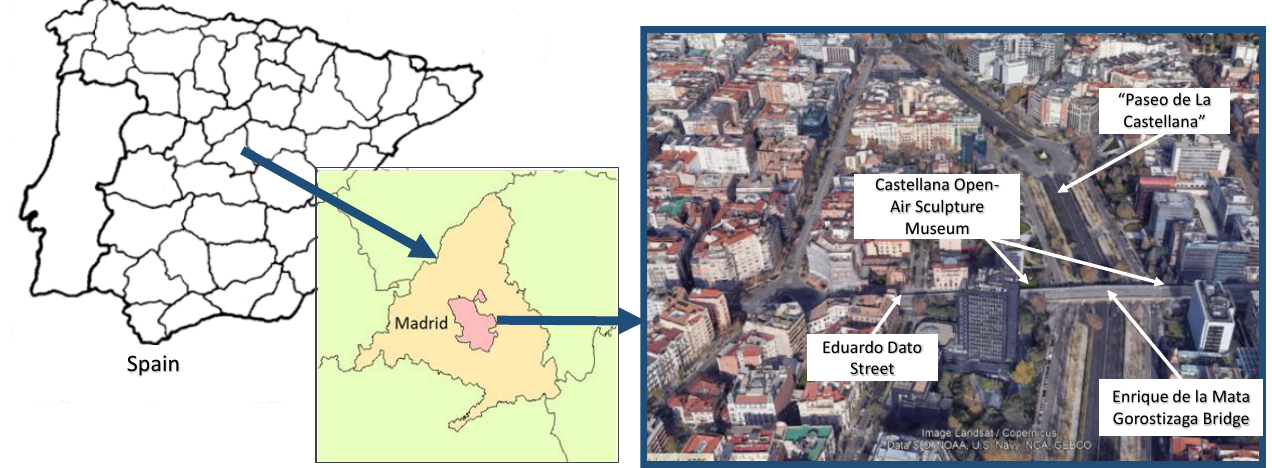
Figure 1. Location of the studied soil profile. The Madrid region forms part of the structural geographic unit commonly called the Central Plateau. In this territory, a series of large physiographical units are distinguished, namely, the Sierra, Piedemonte, Rampa, Campiña, Vegas and P á ramos [35], which con- tribute to form a notable diversity of territorial spaces, landscapes and soils [32,36,37]. Soil diversity is manifested by the presence of Entisols, Inceptisols, Alfisols and Mollisols (following Soil Taxonomy criteria). It is also worth noting the presence of Histosols and Ultisols in certain mountain